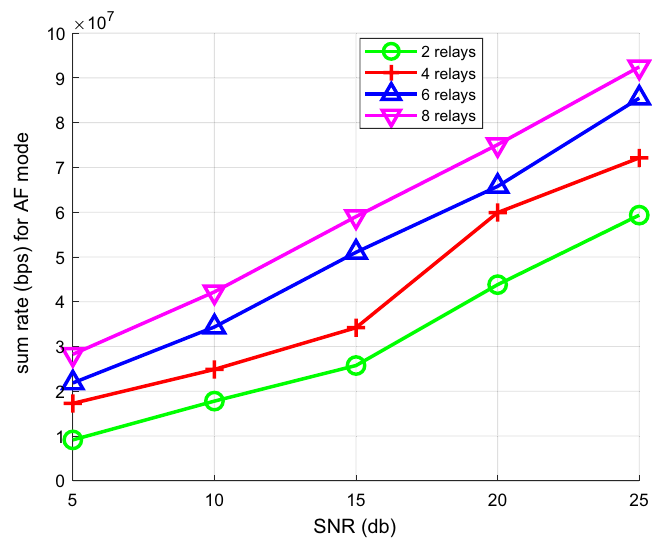
Fig. 4 Sum-rate curves in two-way AF mode. It is the sum-rate curve with different number of relays, and the transmit SNR is from 5 to 25 db in AF mode